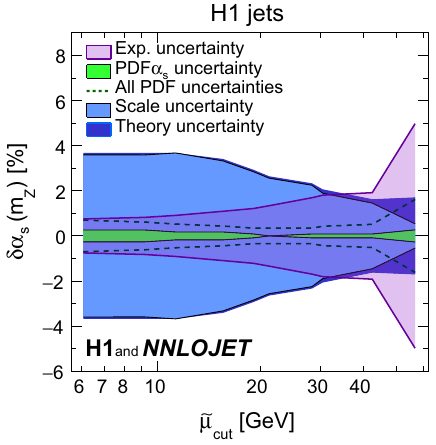
Fig. 10 Uncertainties of the α s fit as a function of the parameter ˜ μ cut which restricts the jet data to high scales. The experimental, scale, PDF α s , quadratic sum of all PDF related uncertainties, and the theory uncertainty are shown